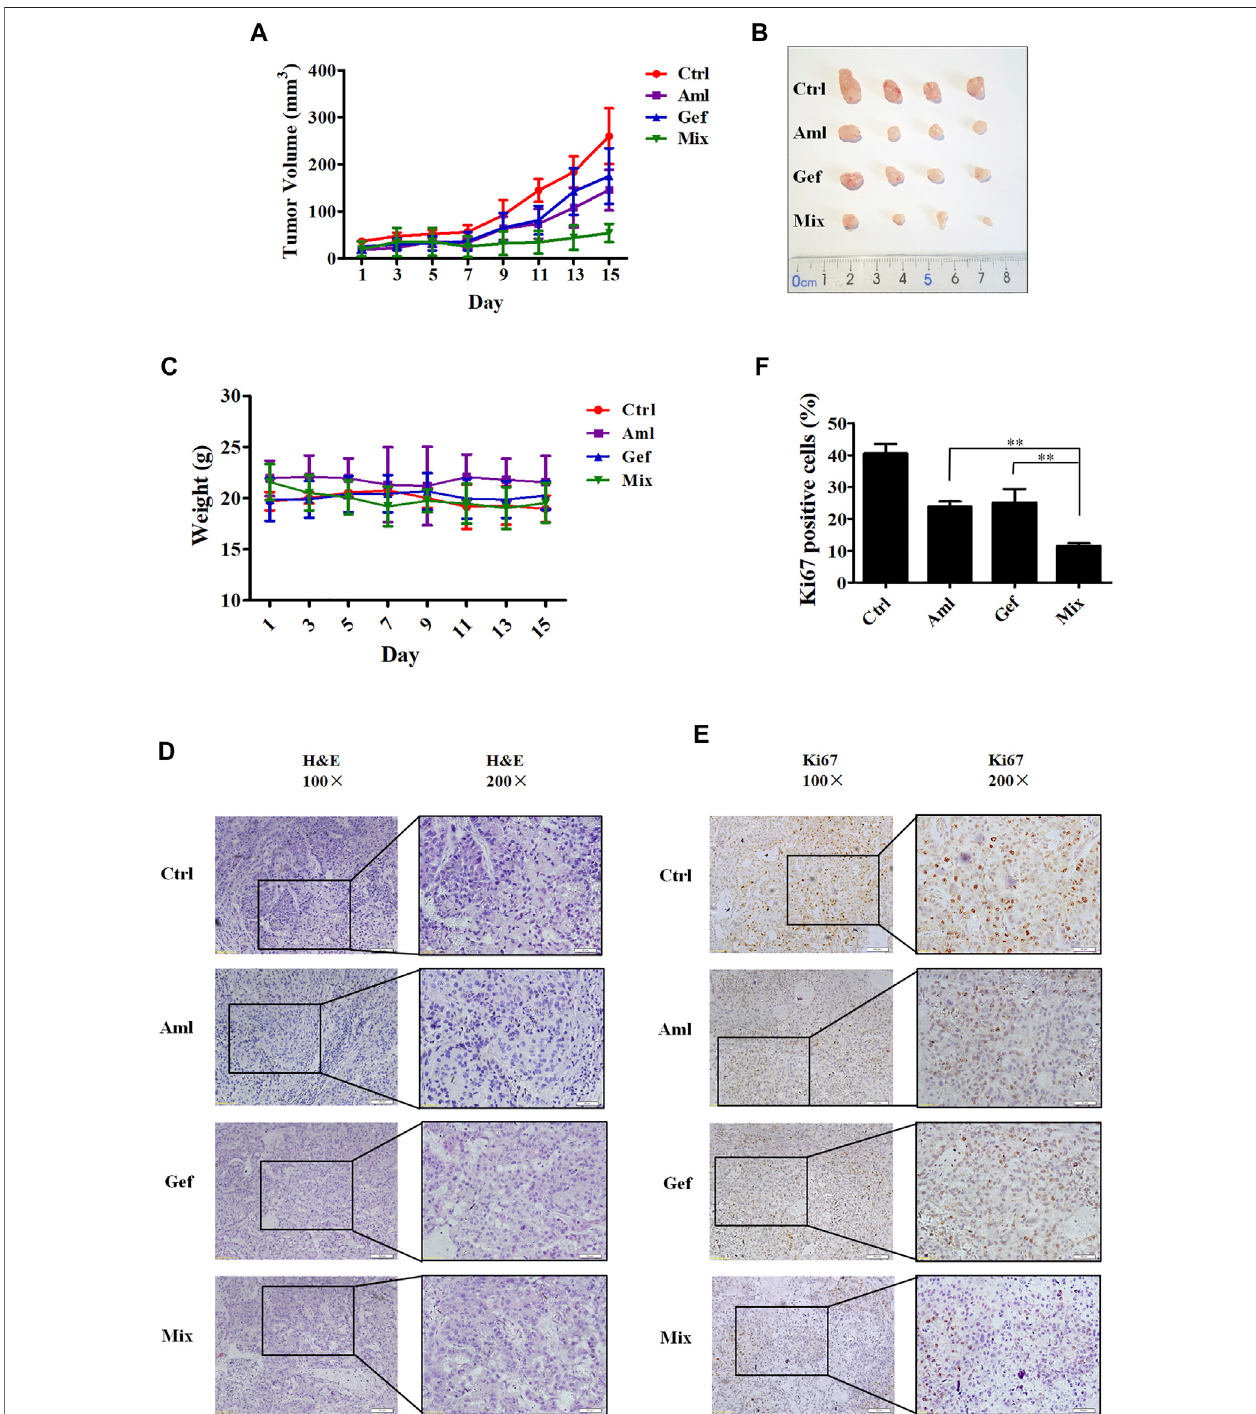
FIGURE5| Amlodipinecombinedwithge fi tinibinhibitstumorgrowthinnudemicebearingA549xenograft.Tumor-bearingxenograftmicewereorallyadministered amlodipine(10 mg/kgeveryotherday)andge fi tinib(50 mg/kgeveryotherday),alone orincombination,for15 days. (A) Tumorvolumes weremeasured everyalternate day. (B) Photographsoftheisolatedtumorsineachgroup. (C) Representativebodyweights ofmiceineachgroup. (D) TumortissueswerestainedwithH&E. (E) Tumor tissueswere stained forthe proliferation markerKi67. (F) Quantitative analysisofthe Ki67 positivecells in tumor sections from mice. Dataare presented asmean ± SD obtained from at least 3 mice. ** p <